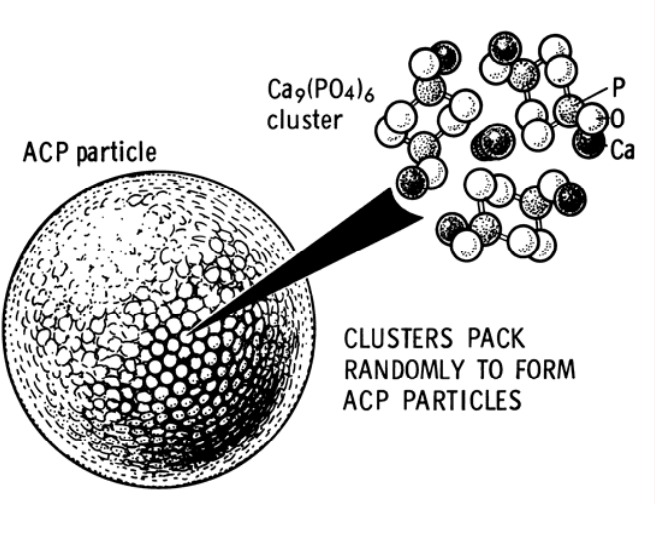
Figure 3. A model of ACP structure. Reprinted from Ref. [190] with